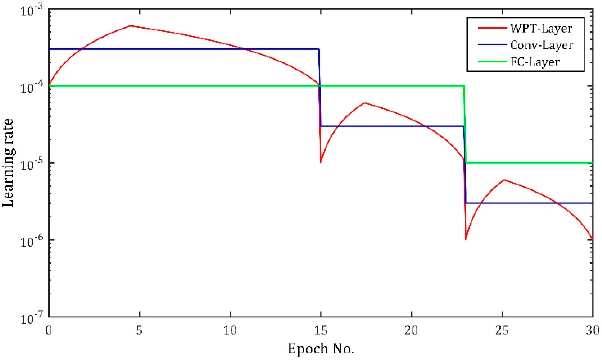
Figure 15. Learning rate schedules used in Case Two.